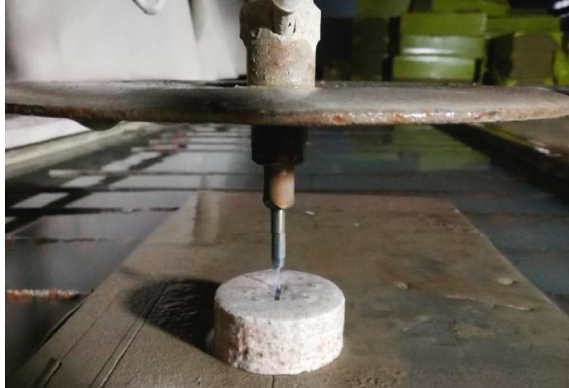
Figure 2: Pre-crack preparation in CSCFBD specimens using a water jet cutting machine [4].